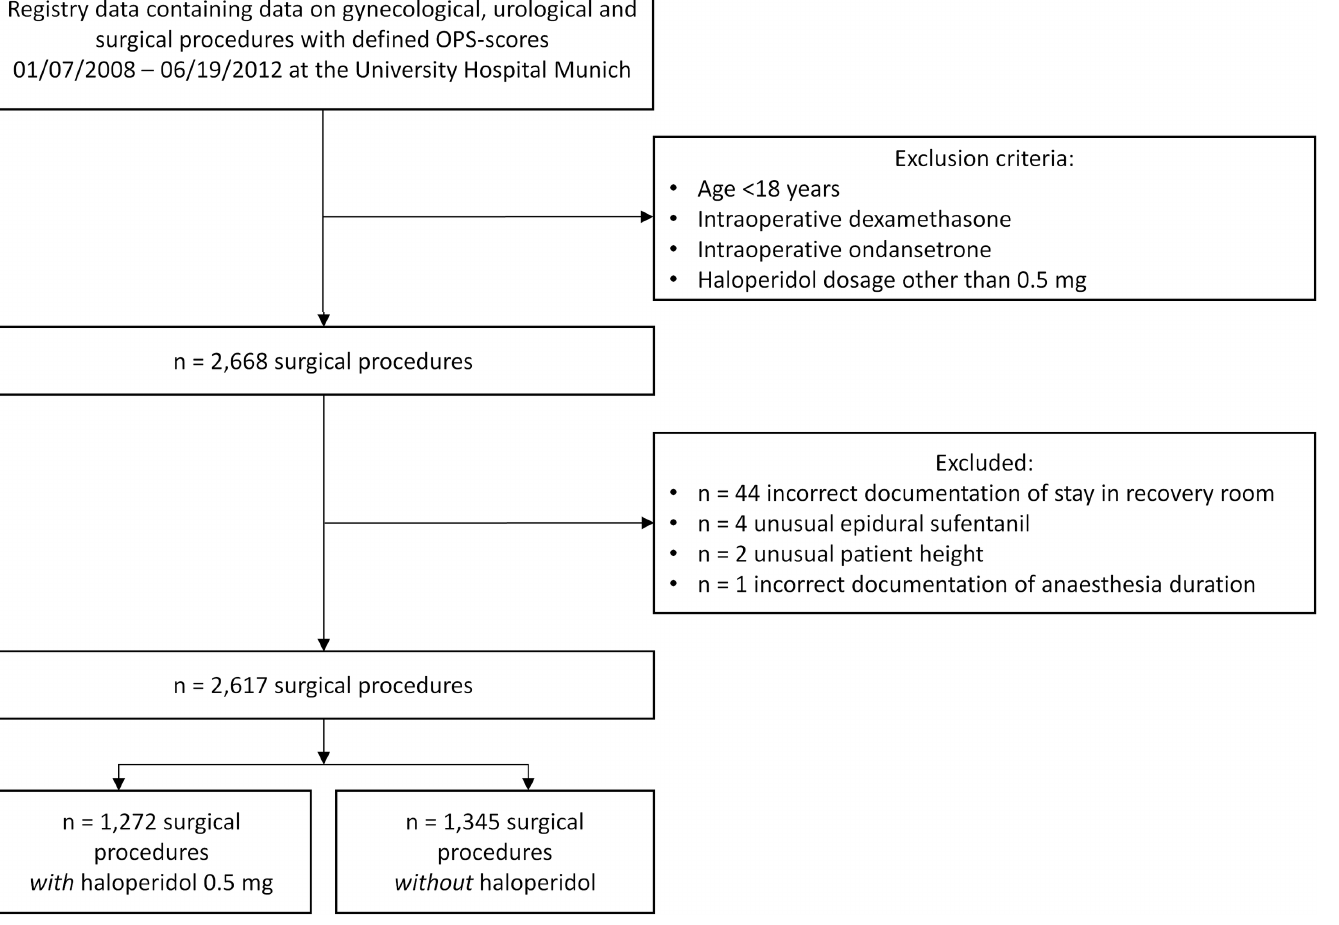
Fig 1. Enrollment. Enrollment of surgical procedures into the